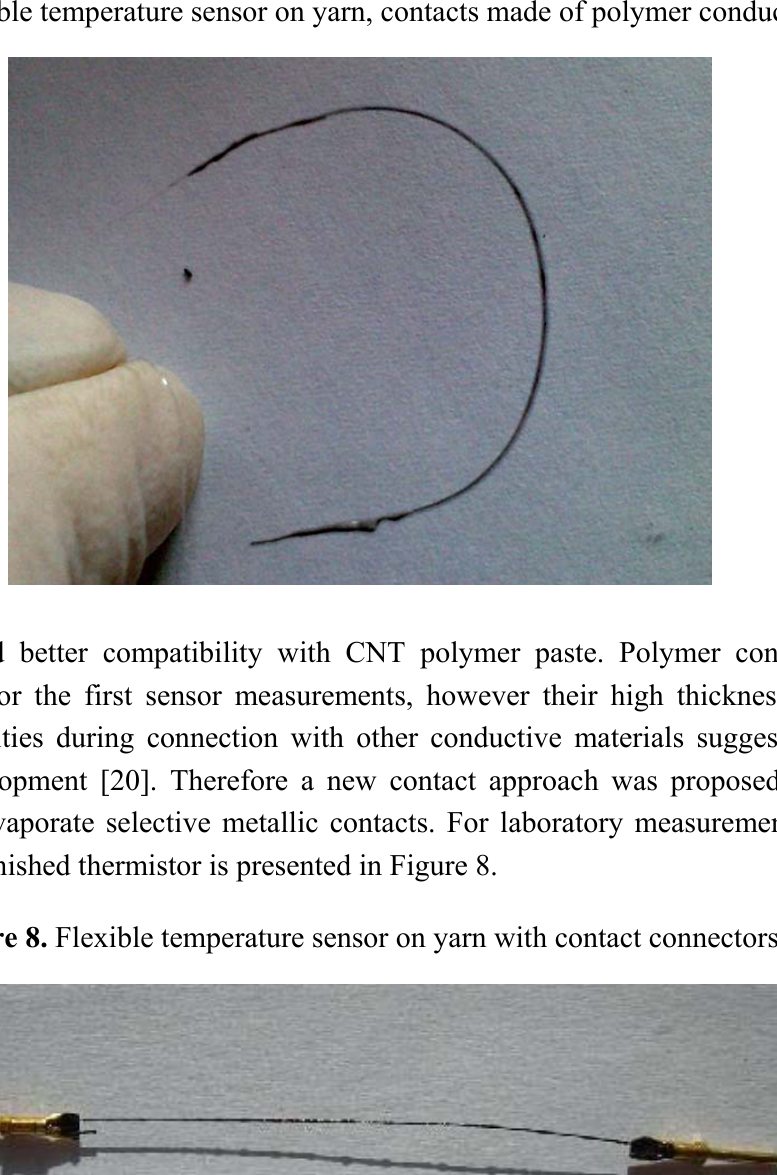
Figure 7. Flexible temperature sensor on yarn, contacts made of polymer conductive paste.